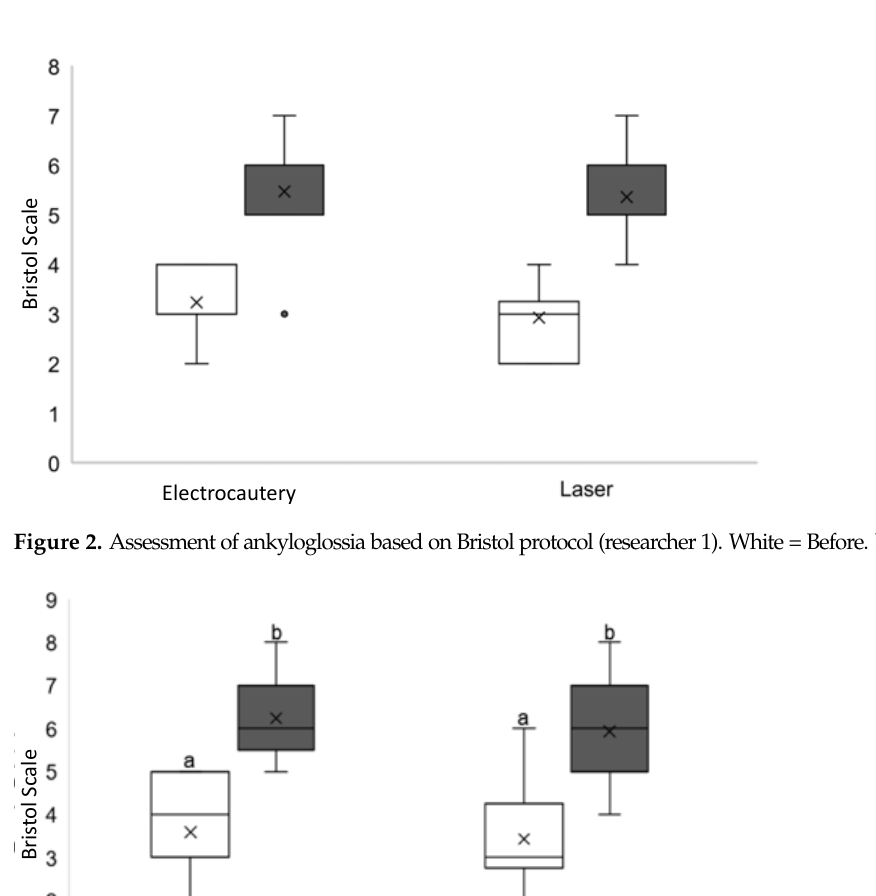
Figure 3. Assessment of ankyloglossia based on Bristol protocol (researcher 2) . White = Before. Black = After.